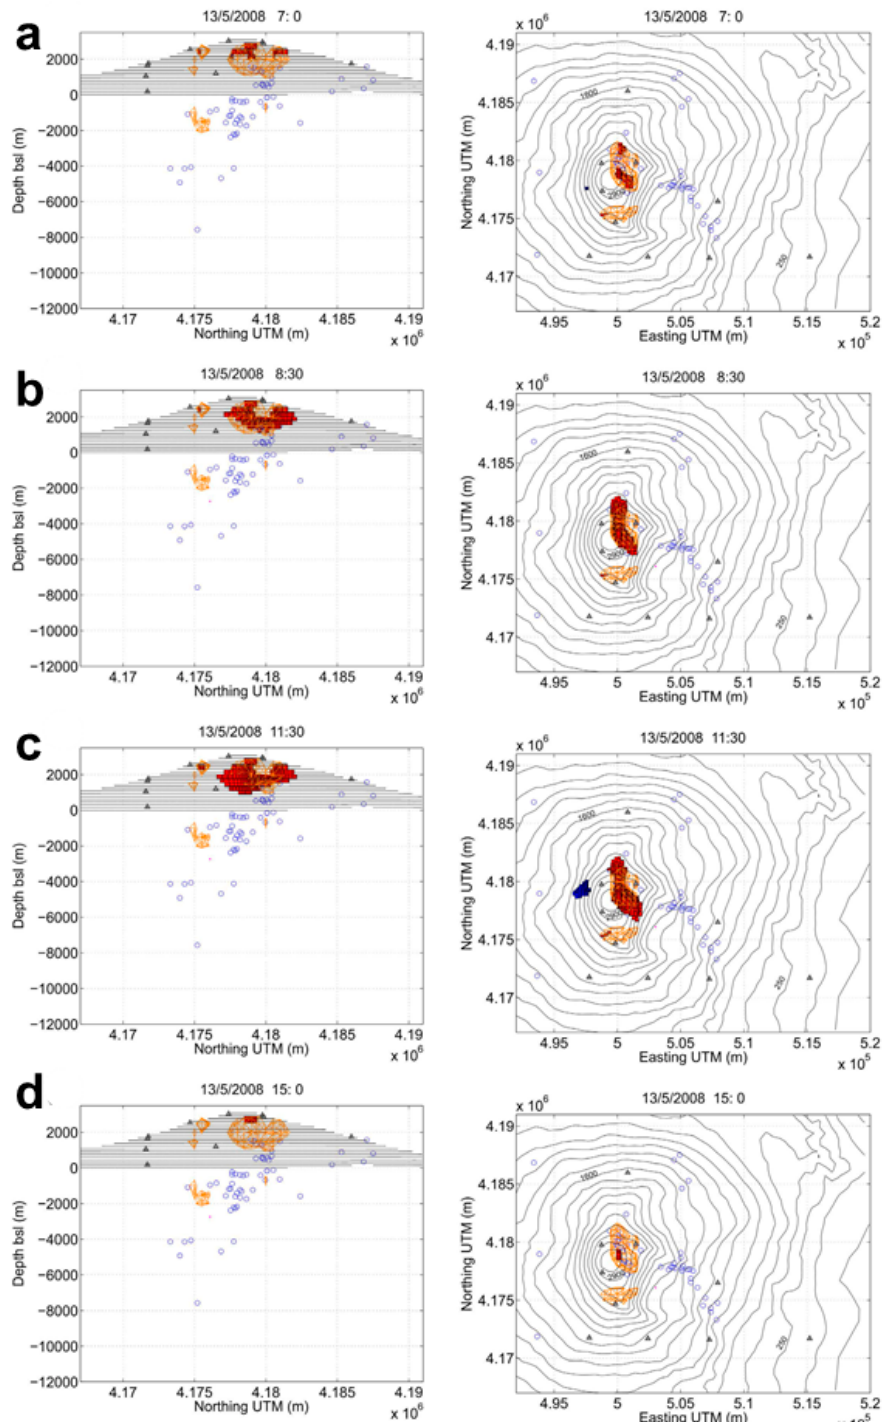
Figure 19. Time sequence of pressurized source models (described by aggregation of parallelepiped cells which map active point pressure sources) corresponding to key instants from the real time inversions during the 13 May 2008, eruption of Mount Etna volcano at di ff erent UTC times: ( a ) at 7:00, ( b ) at 8:30, ( c ) at 11:30, and ( d ) at 15:00. Red volumes are positive-pressure sources while blue volumes are negative pressure sources. Structures marked in orange correspond to the cumulated sources describing the main source structures across the sequence. Contours correspond to surface topography. Gray triangles indicate the location of the GPS stations. Blue circles correspond to location of the earthquakes for 12–14 May 2008